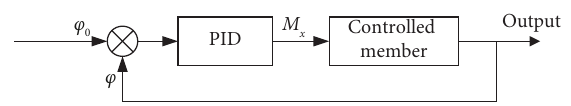
Figure 3: Diagram of the suspension controller. Table 3: Antiroll torque distribution